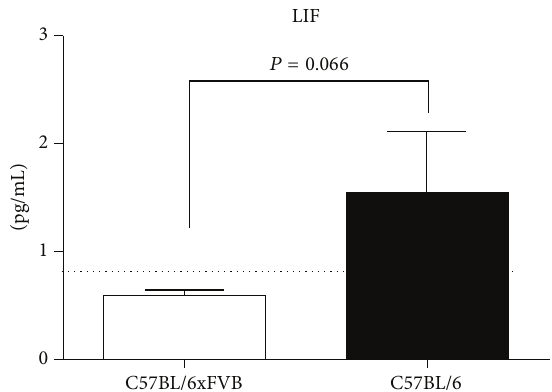
Figure 3: Concentrations of interleukins in serum. Concentrations of IL5, IL7, and LIF were higher in C57BL/6J mice than in C57BL/6JxFVB mice. Concentrations of IL-1 𝛼 , IL9, IL10, IL12p40, IL13, and IL17 did not differ between C57BL/6J and C57BL/6JxFVB mice. Dashed line indicates the detection